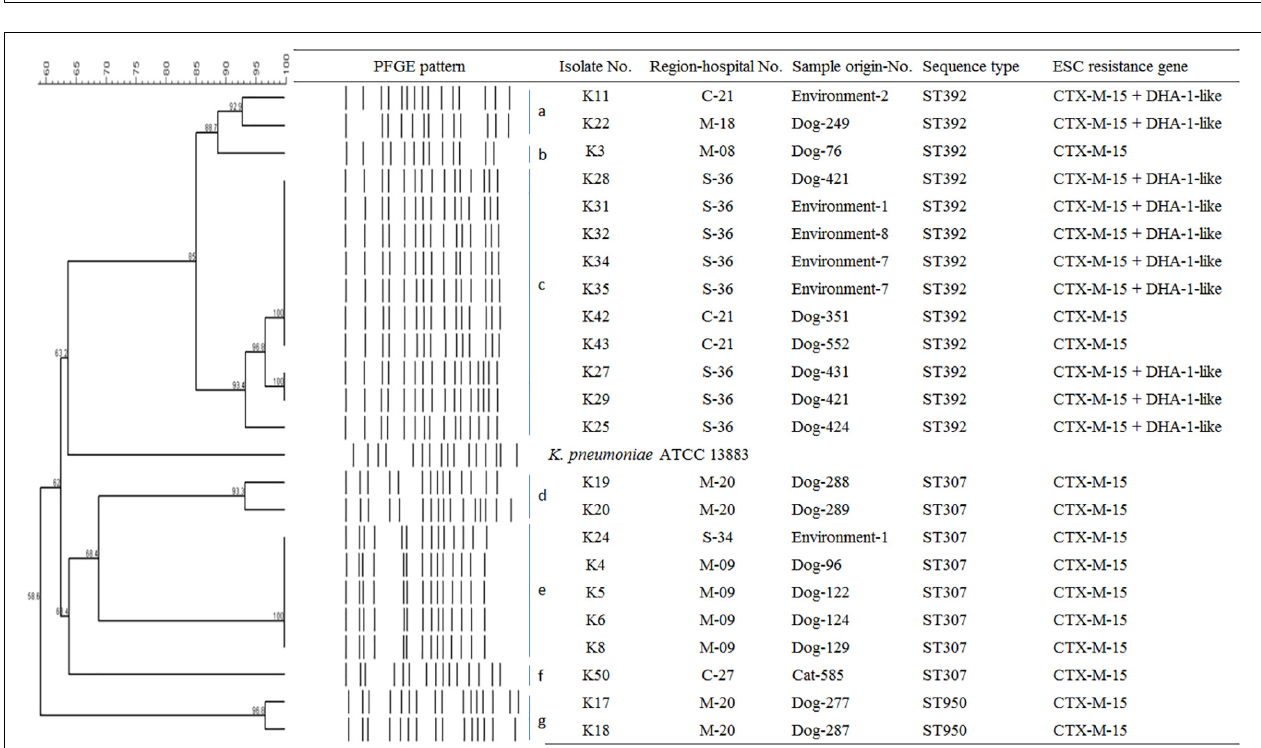
FIGURE 1 | Pulsed-field gel electrophoresis (PFGE) dendrogram of the five CMY-2-like producing E. coli ST405 (This image was modified for illustrative purposes). Owner-566 is a veterinarian in the hospital C-26. Staff-570 is a nurse in the hospital C-26. M, metropolitan region; C, central region; S, southern region.